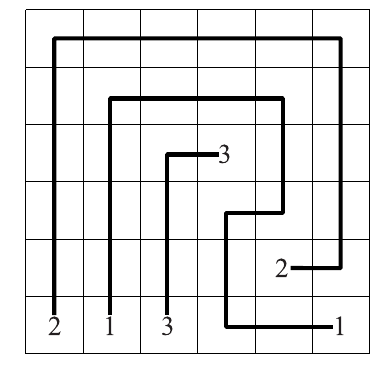
Figure 1. An instance of Numberlink and its solution.